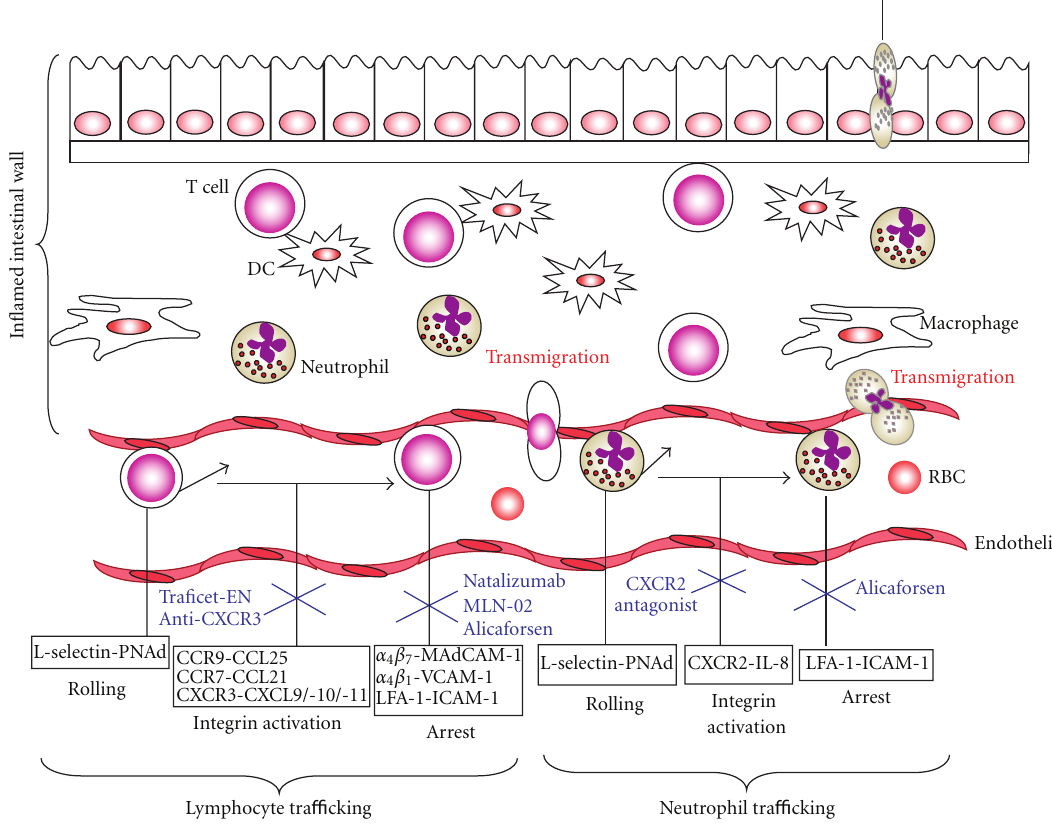
Figure 1: Schematic view of the leukocyte tra ffi cking adhesion cascade in IBD. Leukocytes tether and roll along the vascular endothelium via selectin-mediated adhesion. They are then activated by chemokines into a high avidity, high a ffi nity state so that integrin-mediated strong adhesion and arrest can take place. This prepares the leukocyte for transmigration through the blood vessel wall into the inflamed colon. Chemokine activation can be inhibited by various chemokine/chemokine receptor inhibitors such as the CCR9 small molecule antagonist Traficet-EN, a monoclonal antibody to CXCR3 or a CXCR2 antagonist (shown in blue). Additionally, antagonists of integrin firm adhesion include the anti- α 4 integrin monoclonal antibody Natalizumab, the selective α 4 β 7 small molecule antagonist MLN-02 and the antisense intercellular adhesion molecule-1 (ICAM-1) oligonucleotide Alicaforsen (shown in blue). KO, knock out; LFA-1, Lymphocyte function- associated antigen 1; MadCAM-1, mucosal addressin-cell adhesion molecule 1; PNAd, Peripheral lymph node addressin; RBC, red blood cell; V-CAM-1, vascular-cell adhesion molecule